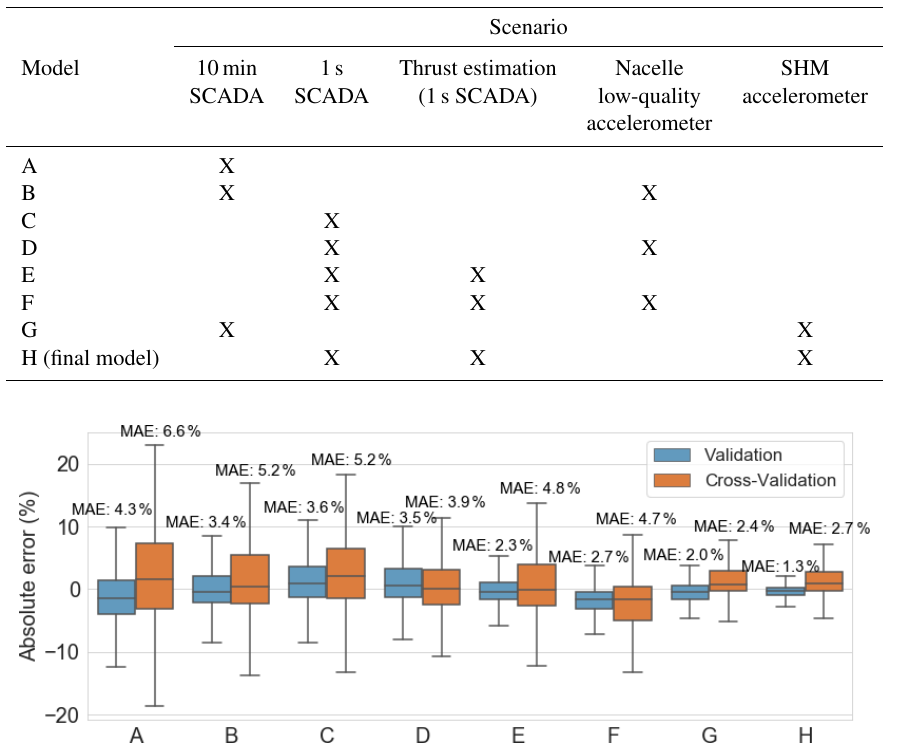
Table 2. Scenarios investigated. Different scenarios imply that different data sources are considered to be available, in line with real-world experience. For example, scenario A considers that only 10min statistics of SCADA are available, while scenario H covers a near-ideal situation only possible on the two SHM turbines. Scenarios D and F are possible at all turbines of the particular farm in this contribution. Note that the access to 1s SCADA inherently implies access to 10min SCADA. Some scenarios exclude the calculation of the 1s thrust load estimation to assess the added value of calculating this type of parameter.